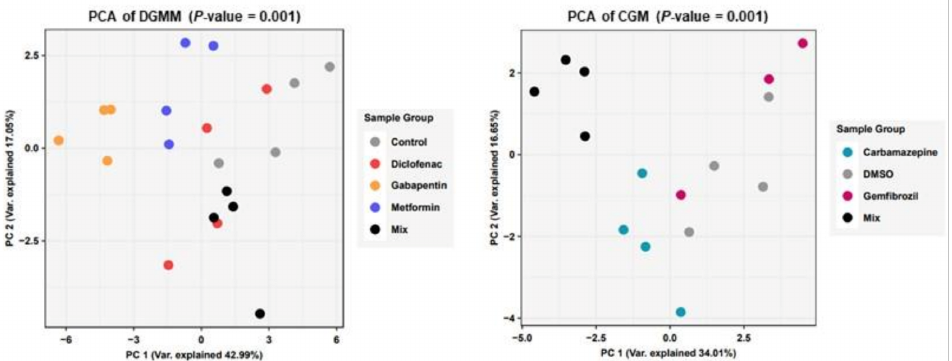
Figure 2. Principal component analysis of metabolite quantifications for different exposure groups of pharmaceuticals. PCA using metabolite abundances as input was performed in R. Differences between treatment groups were calculated with Permanova using Adonis